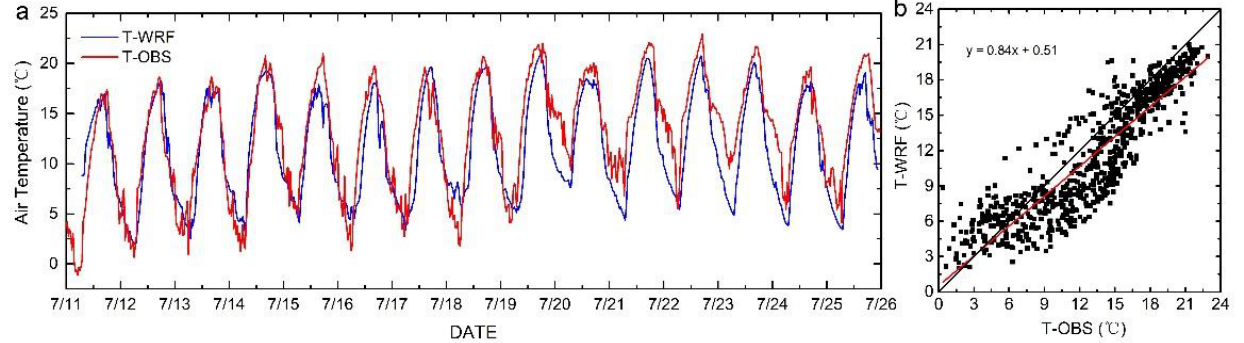
Figure 2. Comparison between temperature simulation results ( a , blue line) and observation data ( a , red line); the slope obtained by ordinary least squares (OLS) is 0.84 ( b , red line).